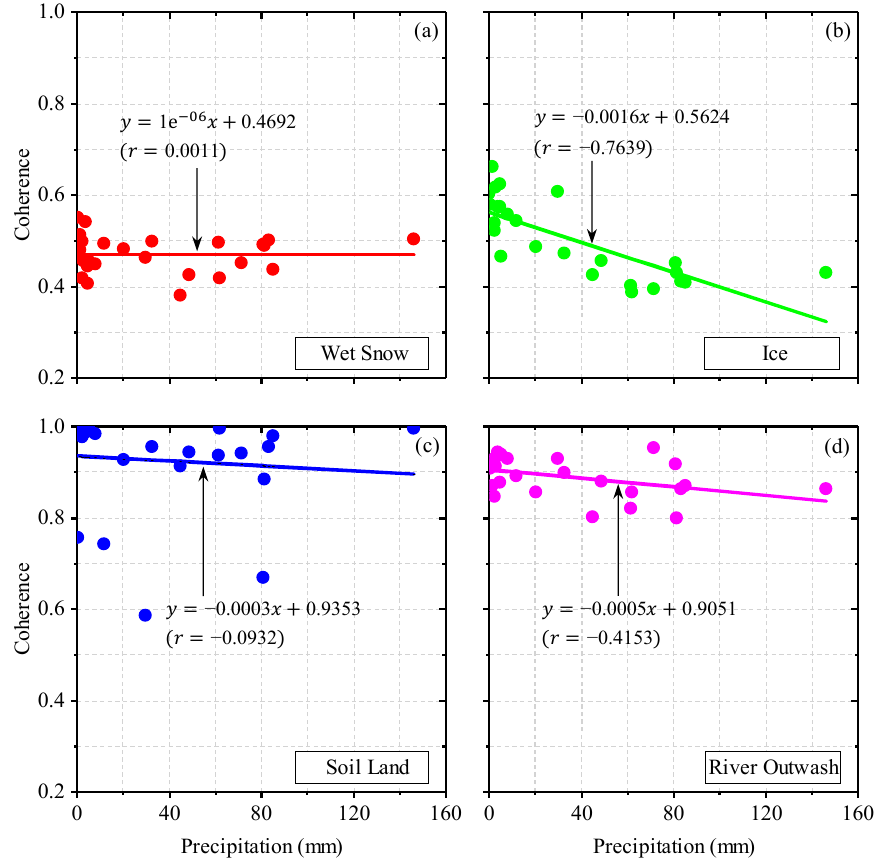
Figure 14. ( a – d ) show the resultant correlation relationship between the coherence mean and the precipitation for the four classes, i.e., wet snow, ice, soil land and river outwash, respectively. Both the linear equation and the correlation coefficient are provided and marked for each class. The data points are denoted by the dots, while the data-fitted linear equation is represented by the solid line.